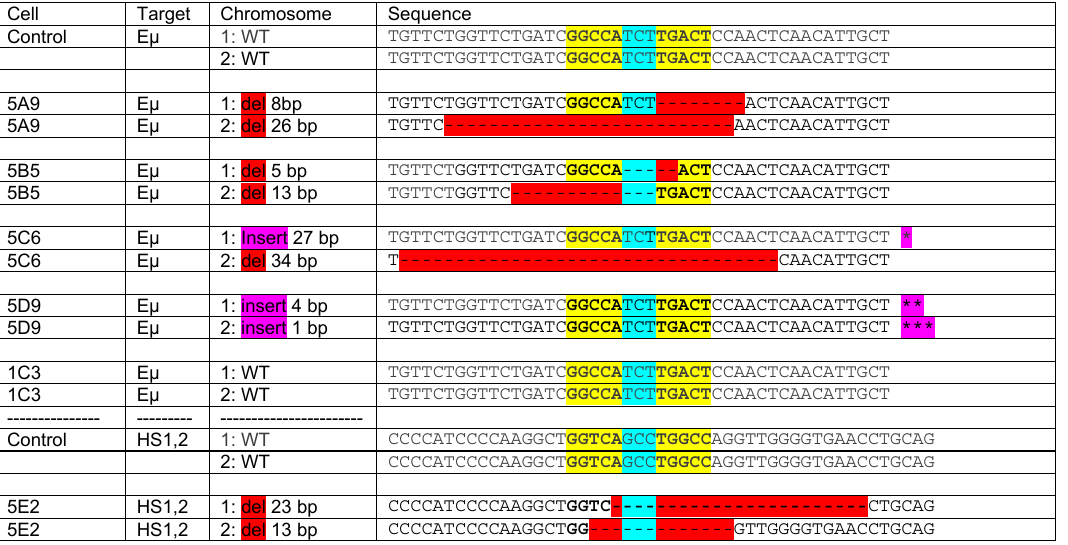
Figure 2. ERE variant sequences among CH12F3 clonal derivatives. CRISPR-Cas9 was used to produce CH12F3 clones with variant ERE. Sequences are shown either in the position of E µ or HS1,2 for each chromosome from each clone. Red indicates a deletion (del). Purple indicates an insertion (insert). The EREs are shown in yellow with the spacer highlighted in blue. A wild-type CH12F3.5B1 cell subclone served as a control. 1C3 was an additional subclone for which there was no sequence change.